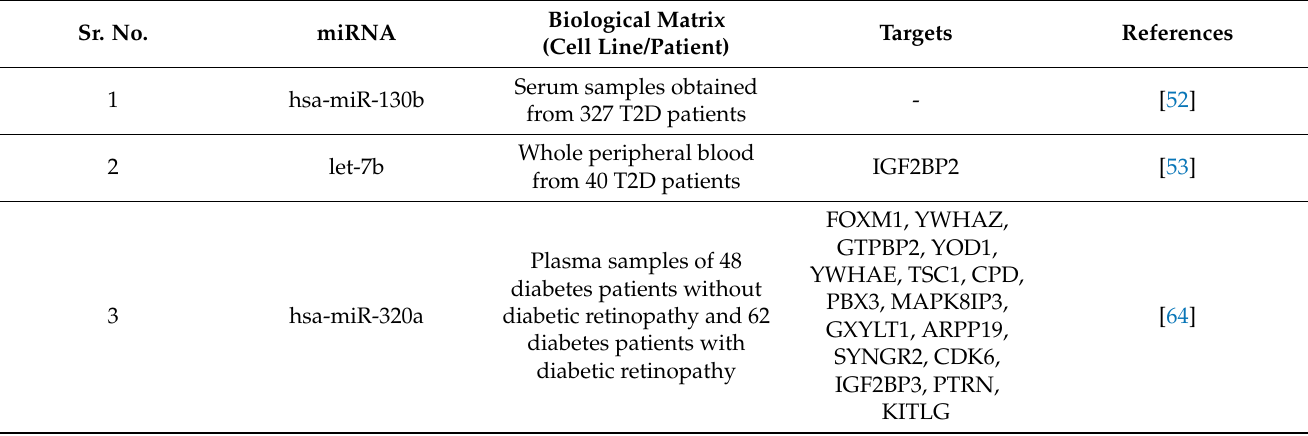
Table 2. Downregulated human microRNAs in